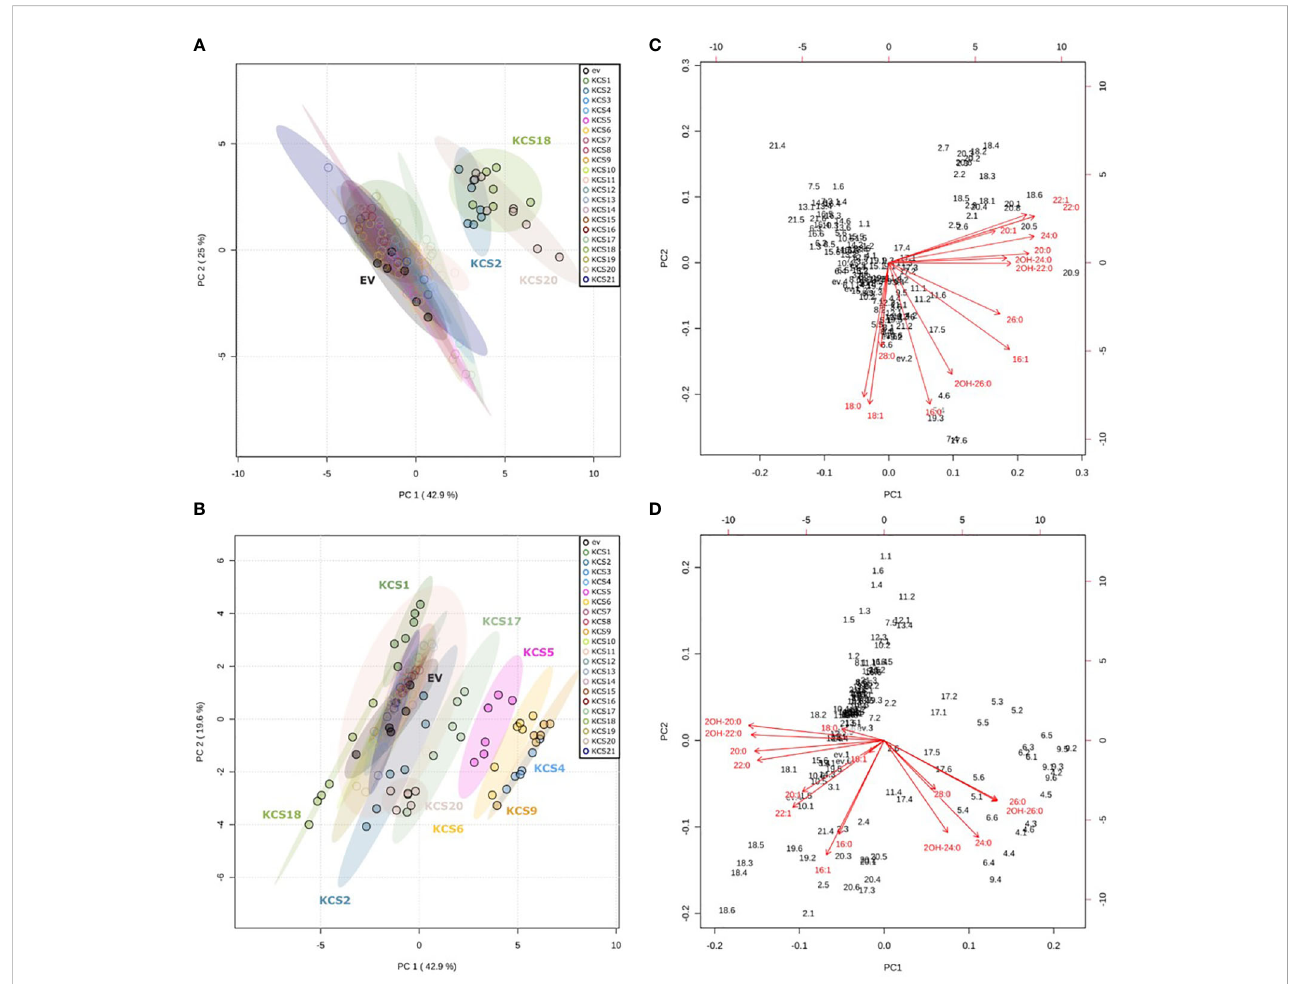
FIGURE 2 Principal component analysis (PCA) of the effect of KCS enzymes on FAMEs pro fi les after expression in InvSc1 TRIPLE and TRIPLE D elo3 strains. Scores obtained for the two fi rst principal components PC1 and PC2 in (A) InvSc1 TRIPLE and (B) InvSc1 TRIPLE D elo3 . Corresponding biplots in (C) InvSc1 TRIPLE and (D) InvSc1 TRIPLE D elo3 . The PCA analyses are of data presented in Figure